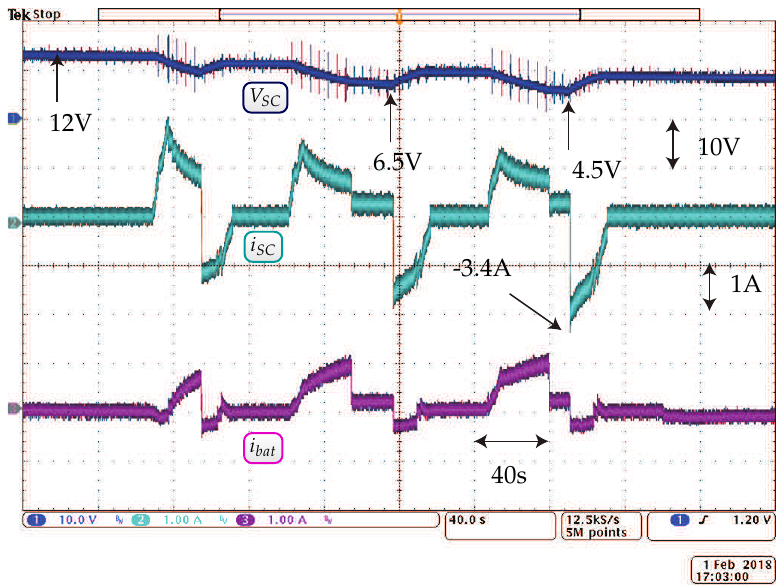
Figure 12. Experimental results for MPC-based two-objectives cost function optimization EMS with three typical stops in the driving cycle of the LR: SC current, SC voltage, and battery